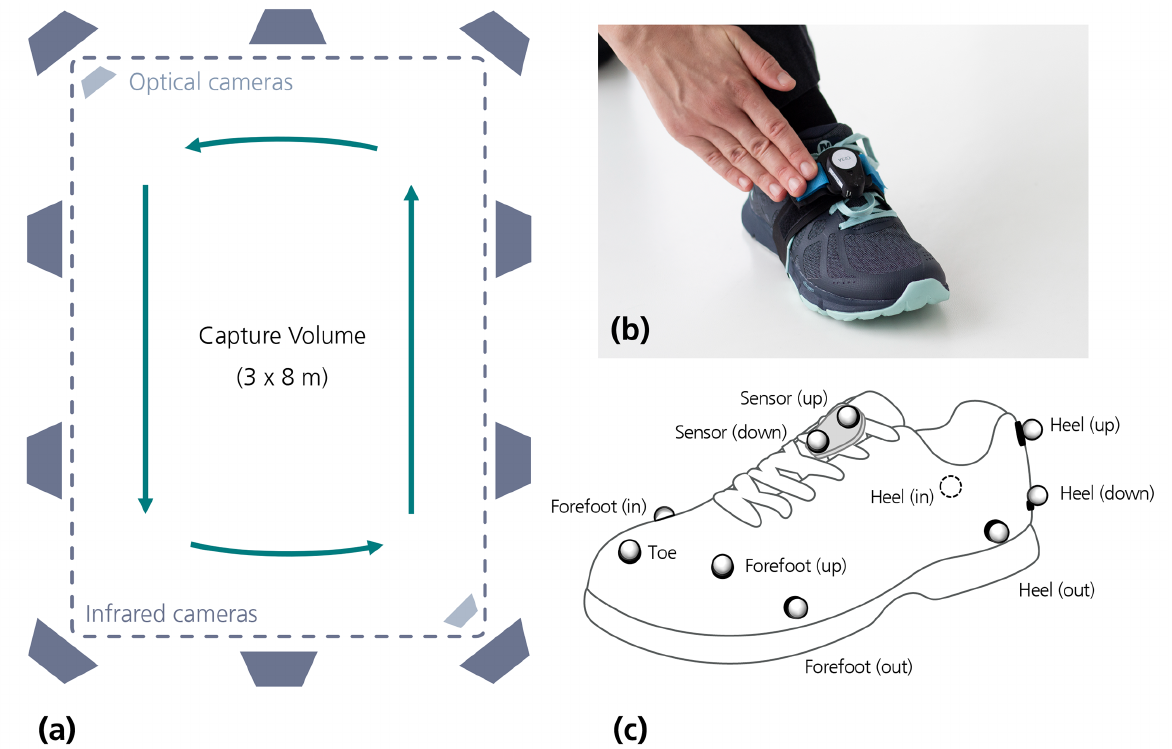
Figure 1. Wearable sensors and reference system: ( a ) Capture volume and camera installation. ( b ) Sensor placement. ( c ) Marker